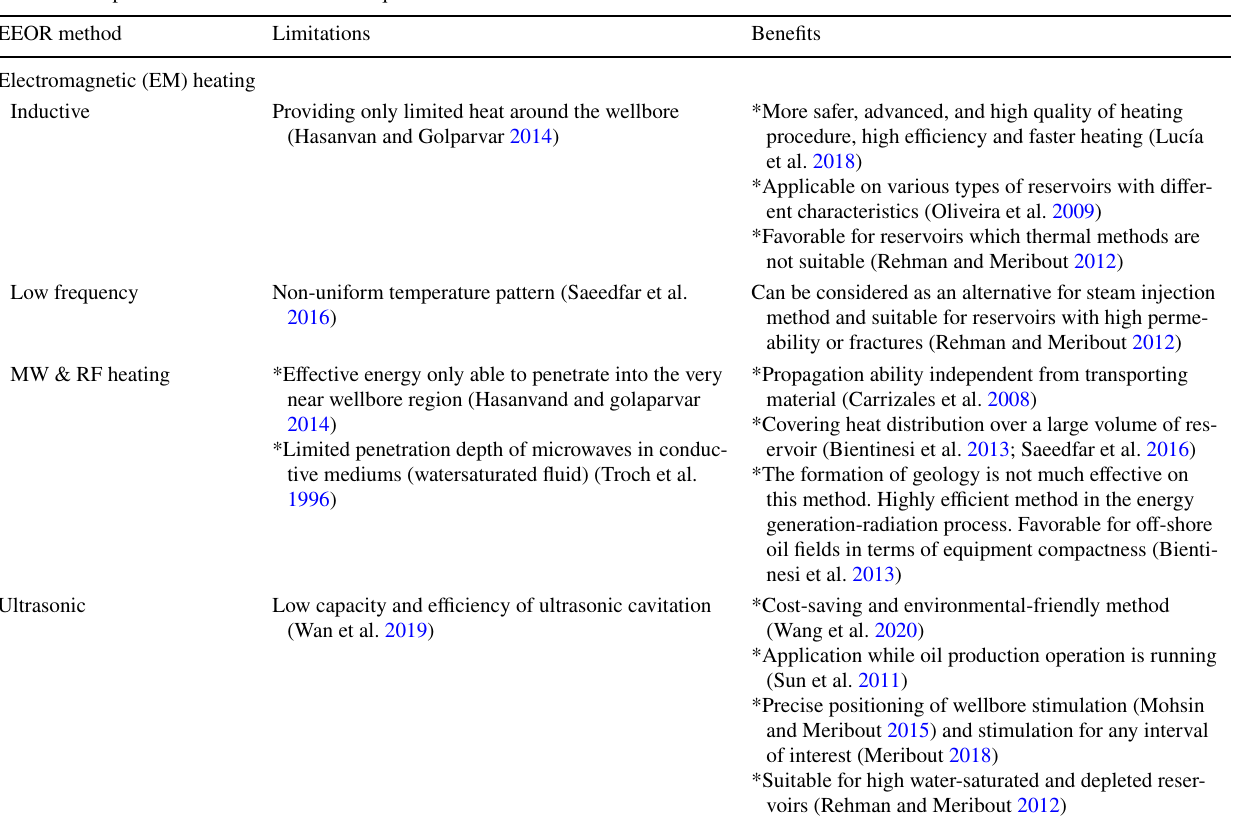
Table 3 Comparisons between EEOR techniques